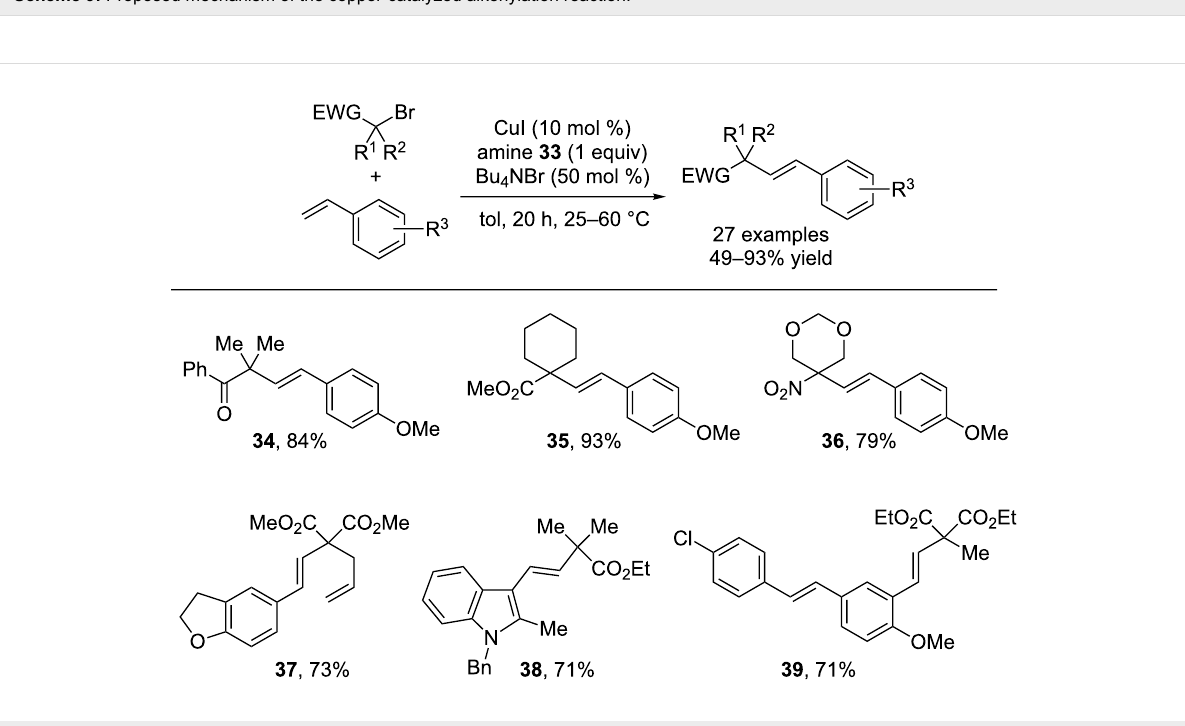
Scheme 10: Scope of the copper-catalyzed alkenylation of tertiary electrophiles.